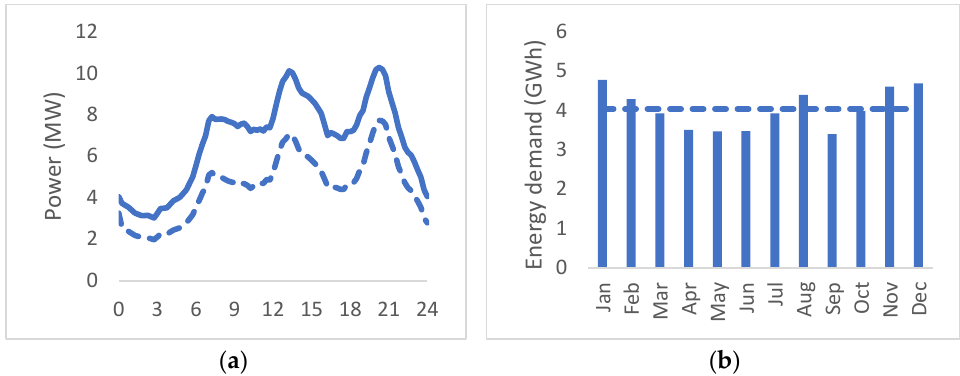
Figure 2. ( a ) Load profiles during week and weekend days; ( b ) monthly energy demand.